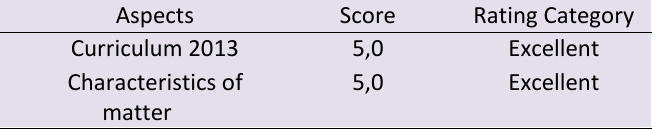
Table 2 . Score Results Per Aspect of Mathematical Materials Expert